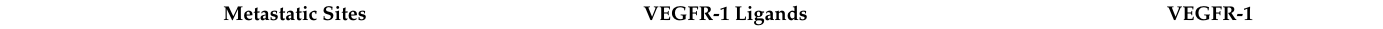
Table 1. Experimental evidence of the role of VEGFR-1 and its ligands in metastasis formation or tumor invasiveness of lung, liver, kidney, bone and pancreatic cancers, glioblastoma, and